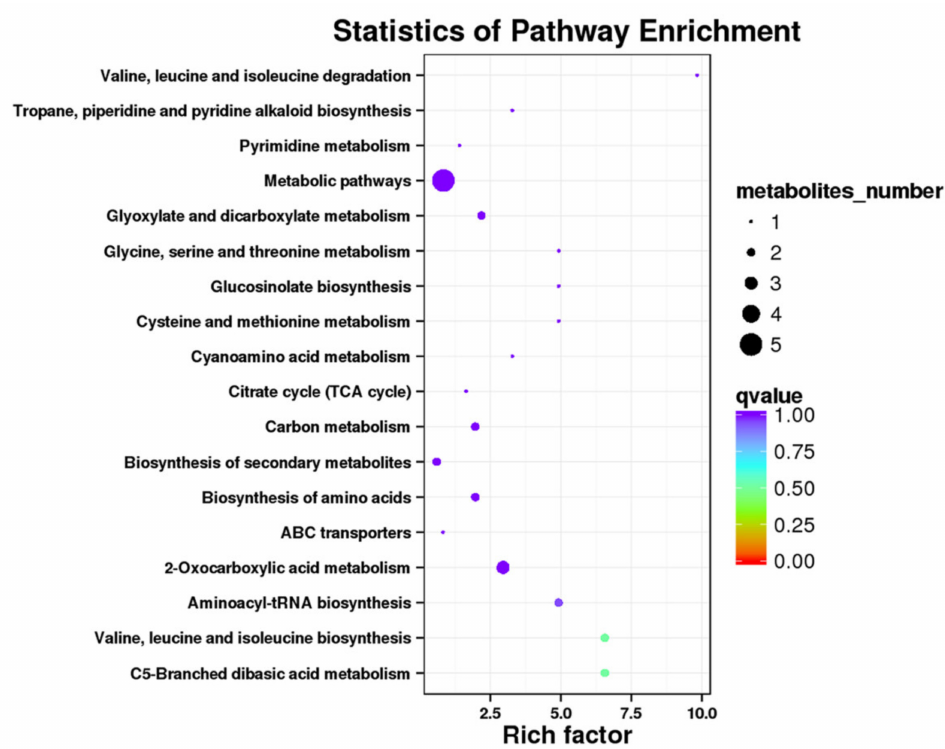
Figure 7. Top 18 enriched pathways for heat-responsive